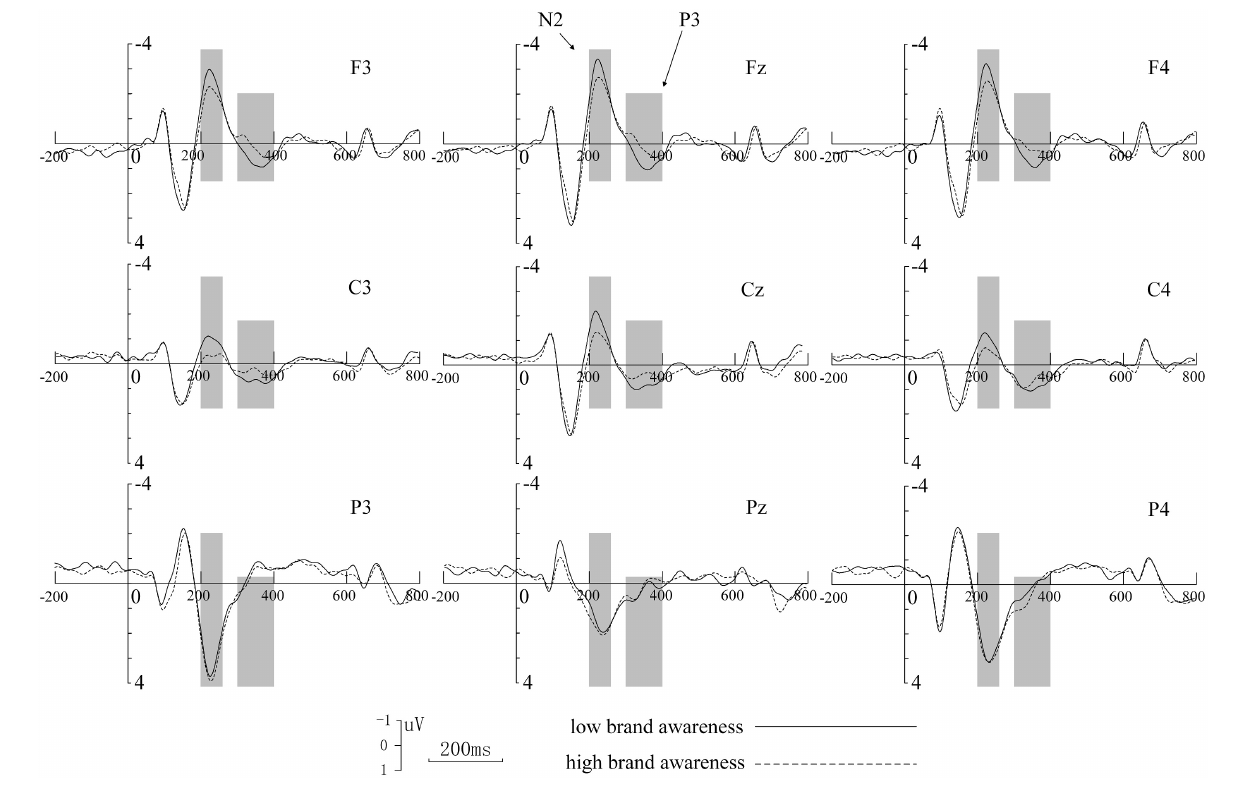
between brand awareness and distribution [ F (2, 30) =